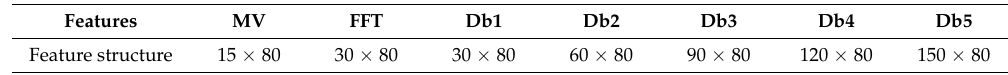
Table 2. Data structure of seven